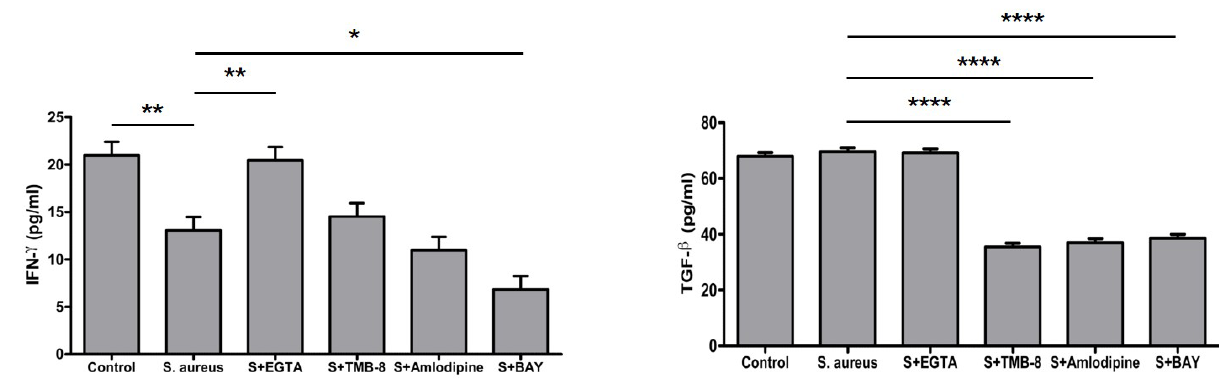
Figure 2: Calcium differentially regulates cytokine profile from macrophages during S. aureus infection. Murine J774 macrophages were incubated with either EGTA or TMB-8 or BAYK8664 or amlodipine for 2h followed by infection with 20 MOI S. aureus infection for 24h. Culture supernatants were scored for the levels of IFN-γ or TGF-β. Data represent the mean ± SD of 3 independent experiments. S indicates S. aureus infection. For IFN-γ, P-value between Control and S. aureus is p=0.0069; S. aureus vs S. aureus + EGTA is p=0.0099 and S. aureus vs S. aureus + BAY is p=0.022. For TGF-β, P-value between-group S. aureus vs S. aureus + TMB8 is p<0.0001; S. aureus vs S. aureus + Amlodipine is p<0.0001 and S. aureus vs S. aureus + BAYK8664is